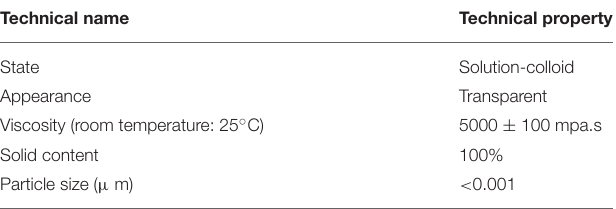
TABLE 1 | Properties of the PU used in this paper.